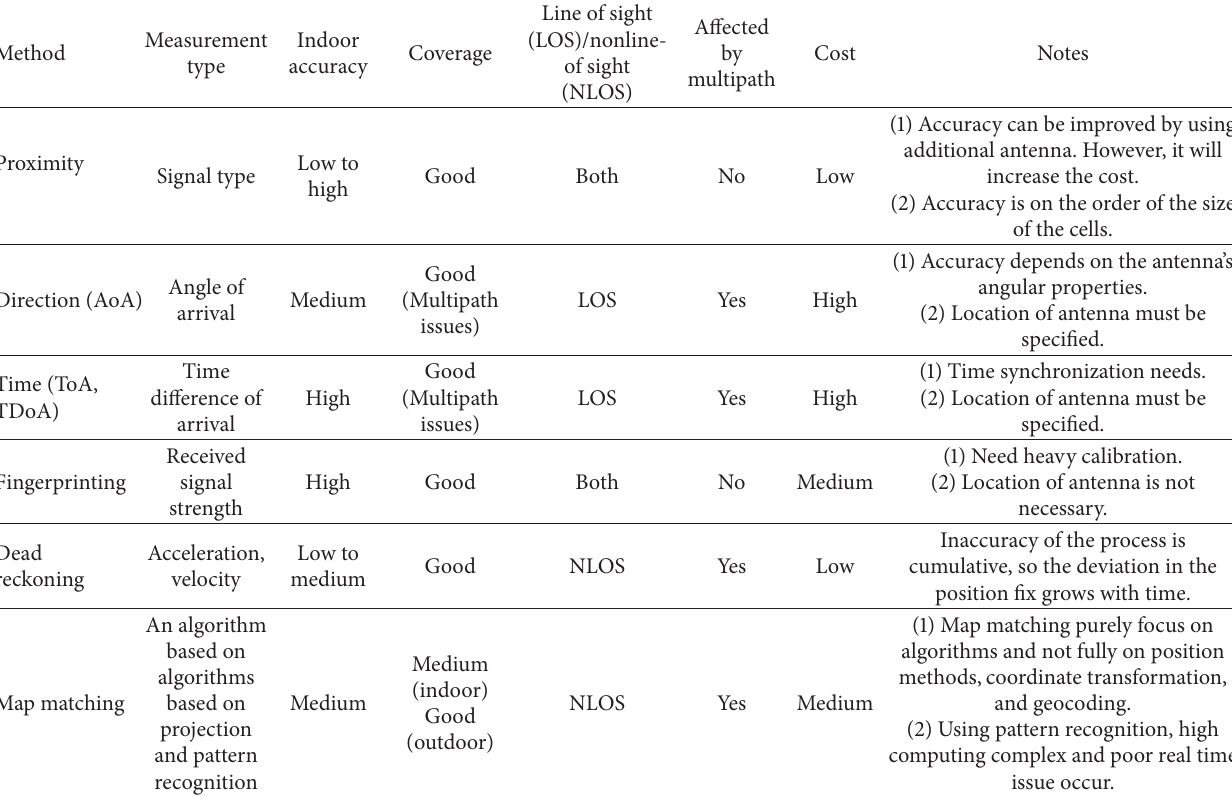
Table 1: Comparisons of indoor position methods.